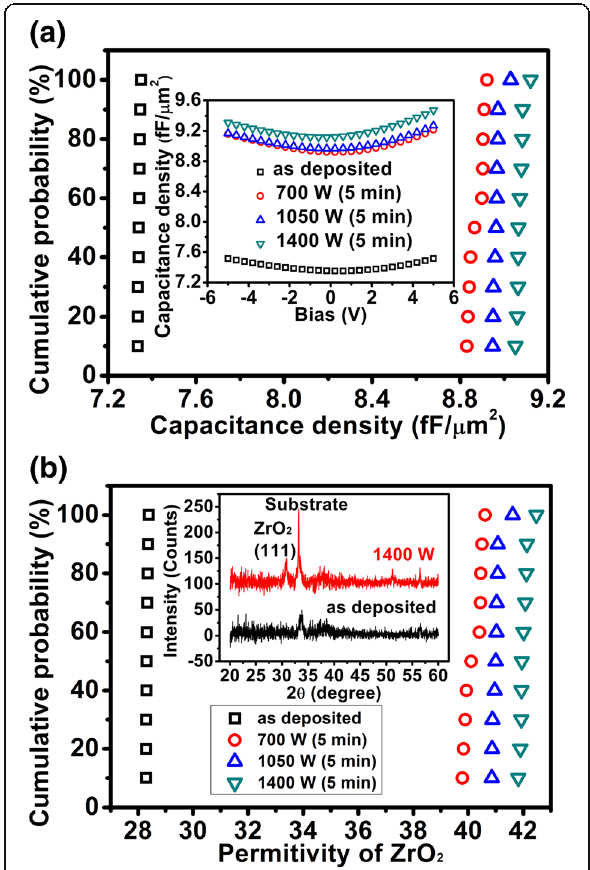
Fig. 2 a The cumulative probability plot of the capacitance density for different samples; the inset displays the capacitance density against the bias. b The cumulative probability plot of the permittivity of ZrO 2 for different samples; the inset exhibits the XRD patterns of the as-deposited and 1400W